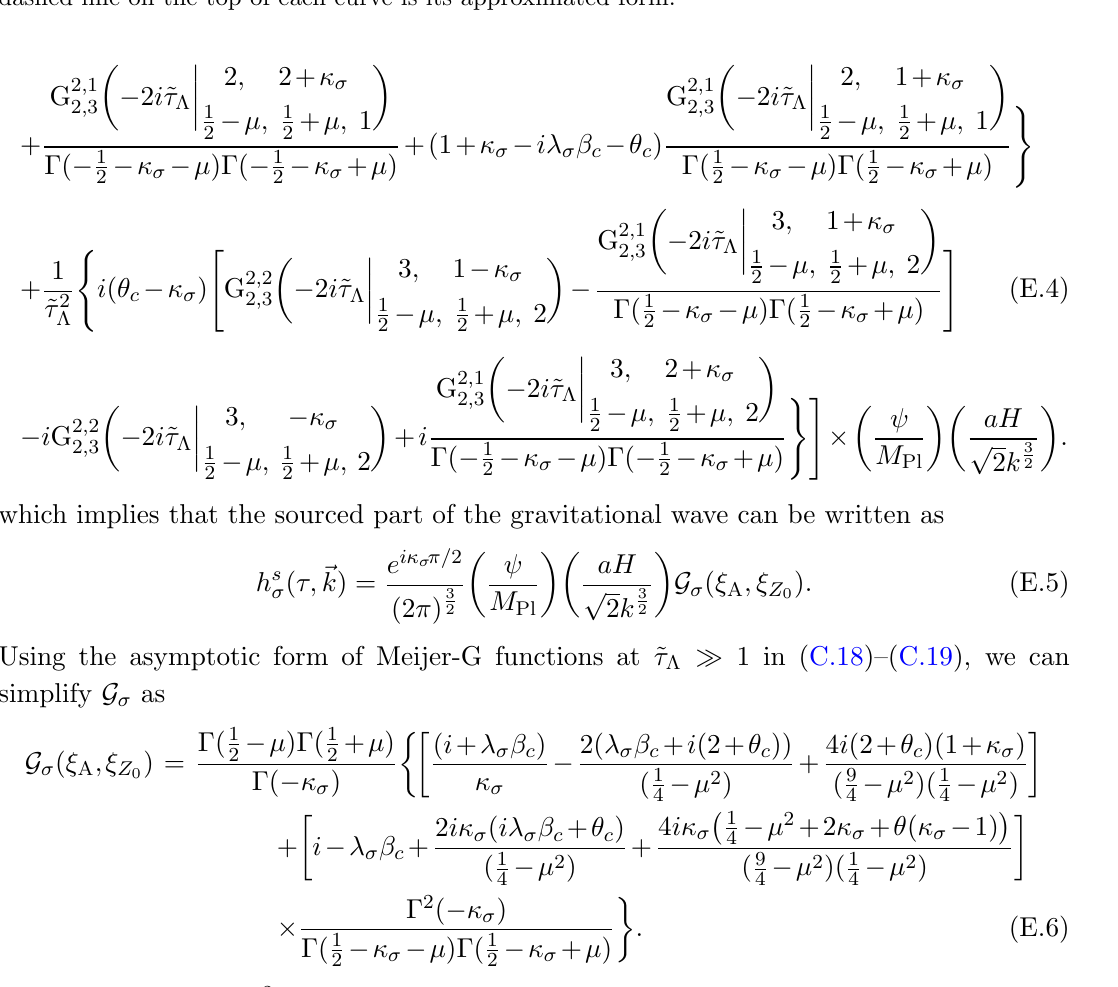
) in (E.6) compared to the approximated from in (E.7) 0 . The solid (black) lines are the exact forms while the 0